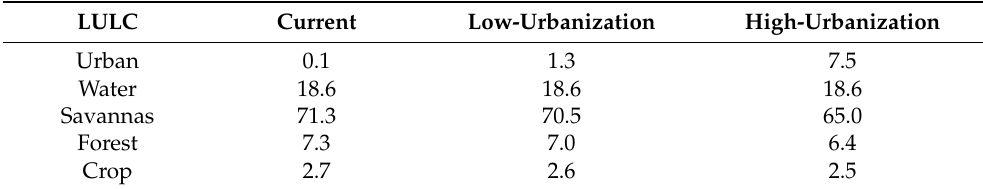
Figure 4. Horizontal distribution of land use and land cover of ( a ) current (default WRF), ( b ) low- urbanization (30%), and ( c ) high-urbanization (99%) scenarios in 2030. Table 3. Percentage of land-use/land-cover for current state, low-urbanization, and high-urbanization scenarios. Each LULC was regrouped into five categories in its similarity. Savannas includes woody savannas, and forest includes all kinds of